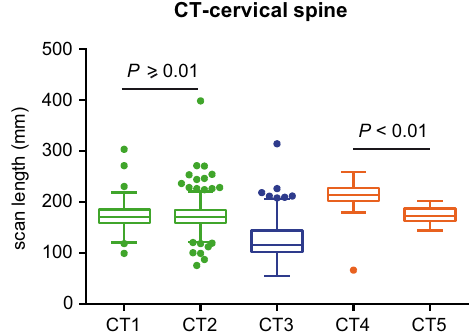
Fig. 5 Detection of differences in the scan length of CT-cervical spine studies between the scanners in hospital C. Box plot of the scan length used for CT of the cervical spine on the five CT systems. Adjusted p values compare CT1 versus CT2 and CT4 versus CT5, Kruskal-Wallis test with post-hoc Dunn test. Adjusted p values not shown on the graph are below 0.01